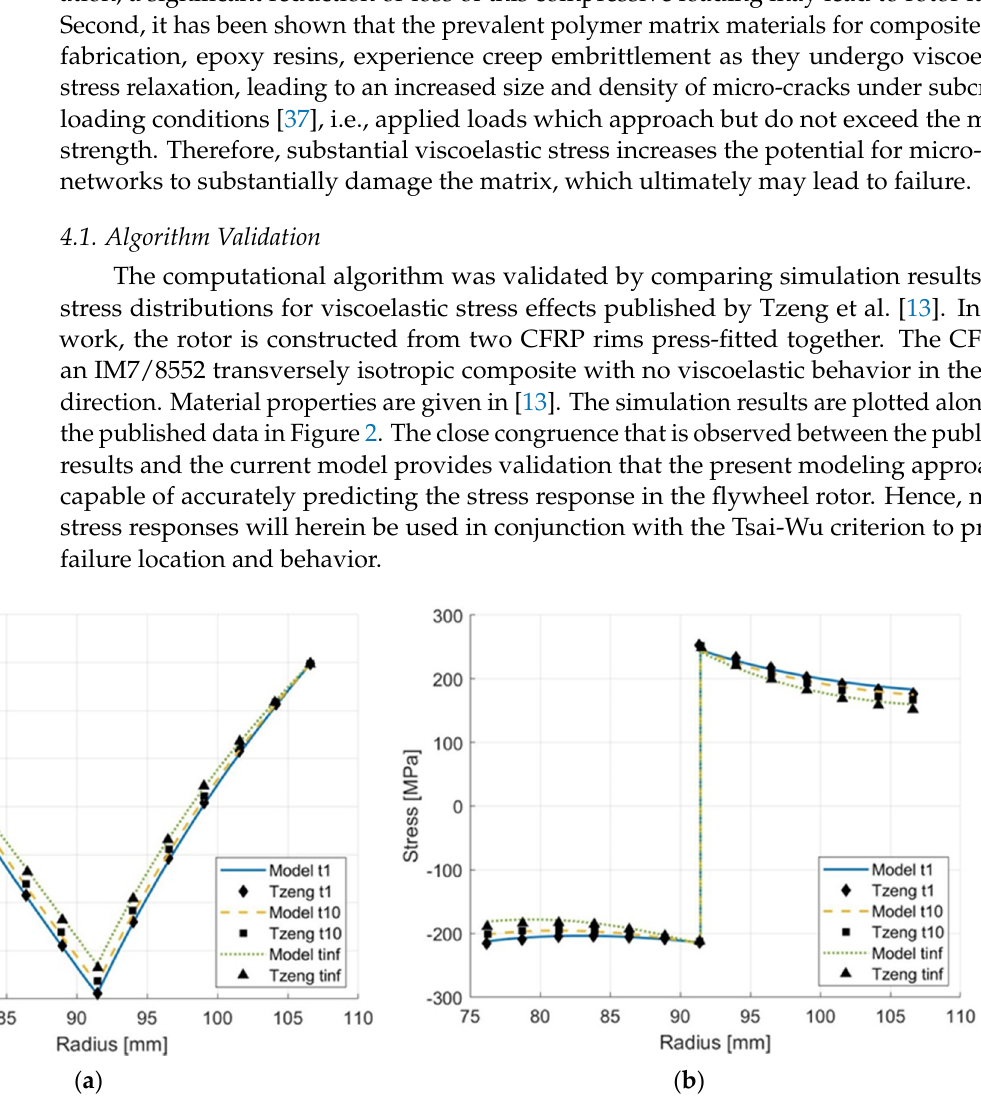
Figure 2. Radial ( a ) and circumferential ( b ) stress distribution comparison between the current model and Tzeng et al. [13] for a two-rim press-fit CFRP flywheel rotor.